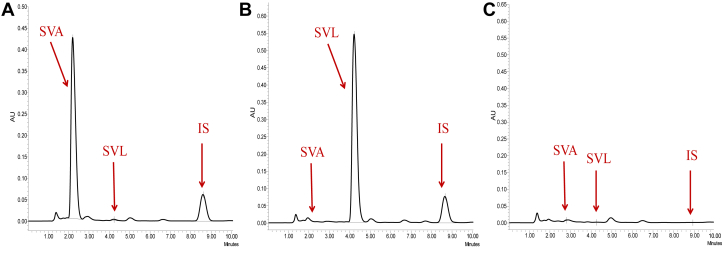
HPLC chromatograms of (A) SVA spiked into Dulbecco's modified eagle medium (pH 7.4) with internal standard (IS = 4,4-dichlorodiphenyltrichloroethane), (B) SVL spiked into Dulbecco's modified eagle medium (pH 7.4) with internal standard (IS = 4,4-dichlorodiphenyltrichloroethane), (C) blank culture medium. SVA, simvastatin hydroxy acid; SVL, simvastatin lactone; IS, internal standard.